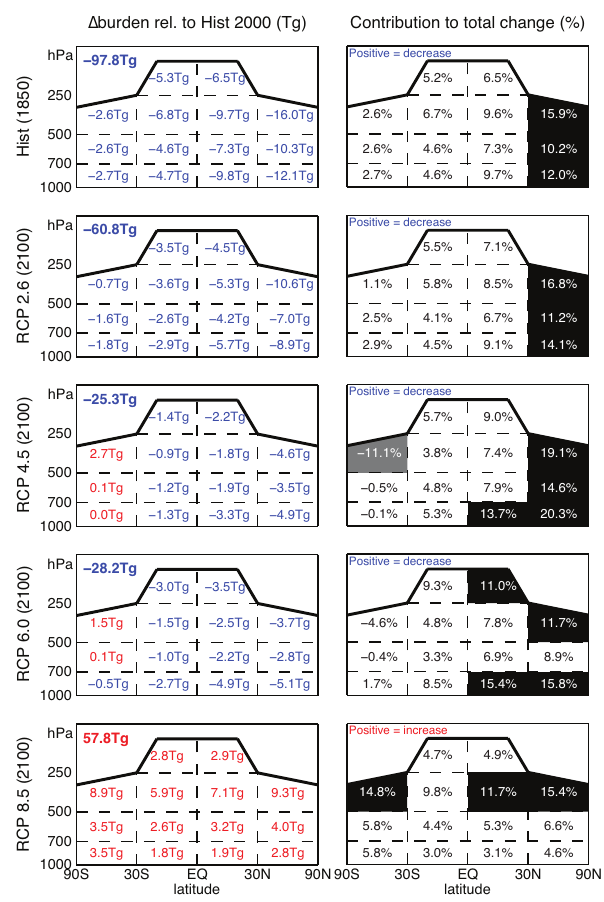
Fig. 8. ACCMIP ensemble mean change in the tropospheric ozone burden relative to the Hist 2000 simulation viewed in Lawrence et al. (2001)-style boxes (see also Fig. 3b), for (top to bottom) the Hist 1850, RCP2.6 2100, RCP4.5 2100, RCP6.0 2100 and RCP8.5 2100 simulations. The left hand column shows the absolute dif- ference in ozone burden for the different boxes (red/blue for in- crease/decrease), with the tropospheric total change indicated in top left of each panel. The right hand column shows the fractional (%) contribution of each box to the overall change in the tropospheric burden. A positive value indicates that the box’s change is the same sign as the overall change. Boxes with a fraction larger than 10% are